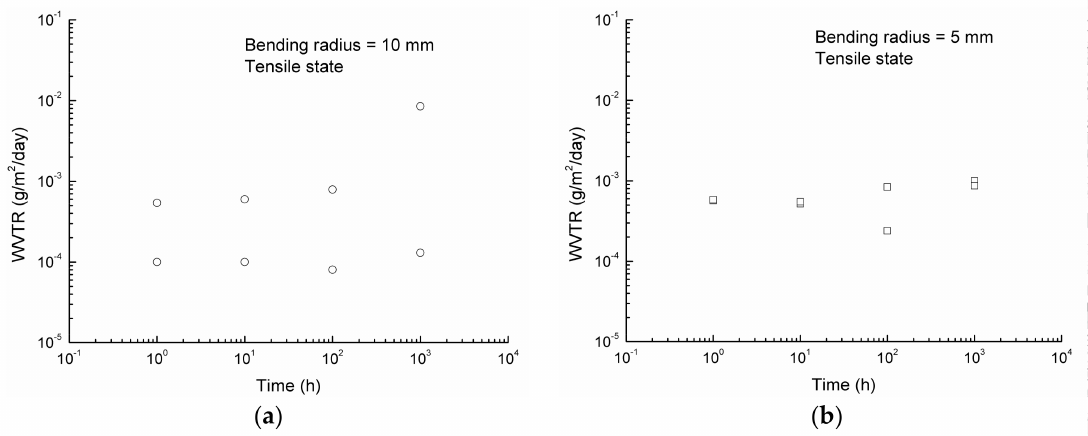
Figure 6. WVTR change of barrier film bent in tensile state: ( a ) bending radius of 10 mm; ( b ) bending radius of 5